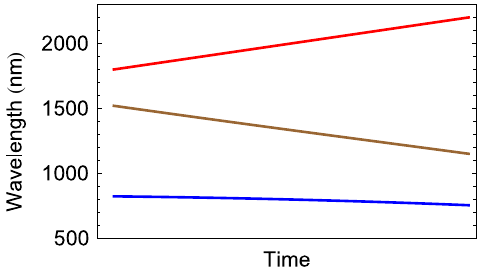
FIG. 5. Chirp can be used on both the signal and the pump to optimize the phase matching. For a linear chirp of the signal (red), the calculation shows the required chirp of the pump (blue) and the resulting idler (brown) needed to obtain perfect phase matching in a BBO crystal optimized for the type I mixing process 2000 nm þ 1333 nm ¼ 800 nm